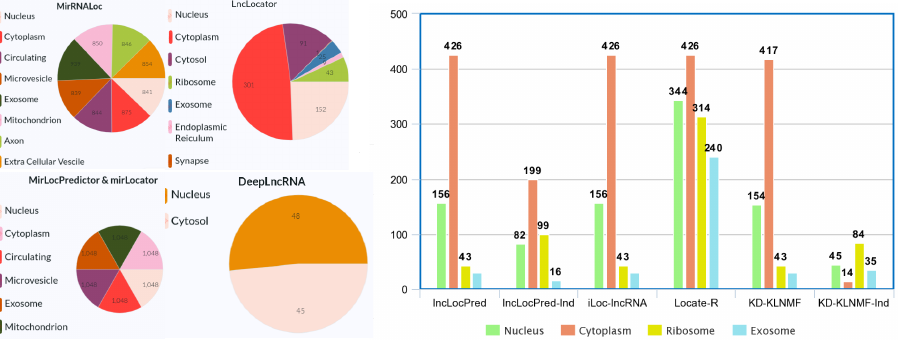
Figure 4. Statistics of Different Benchmark Datasets used in the Literature to Evaluate the Performance of ncRNA Sub-Cellular Localization Predictors